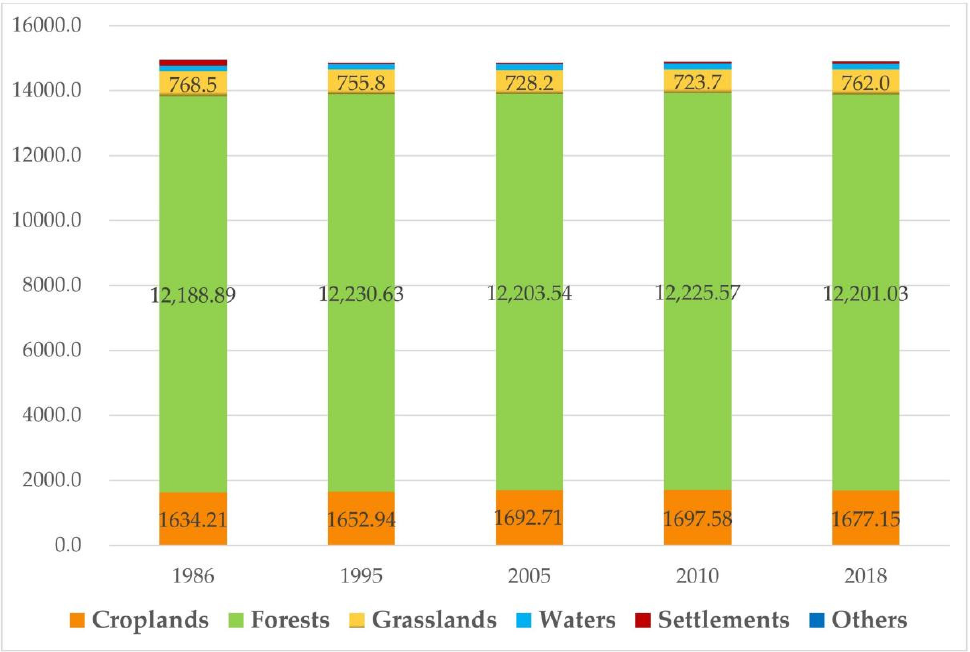
Figure 4. Statistics of the landscape changes from 1986 to 2018.